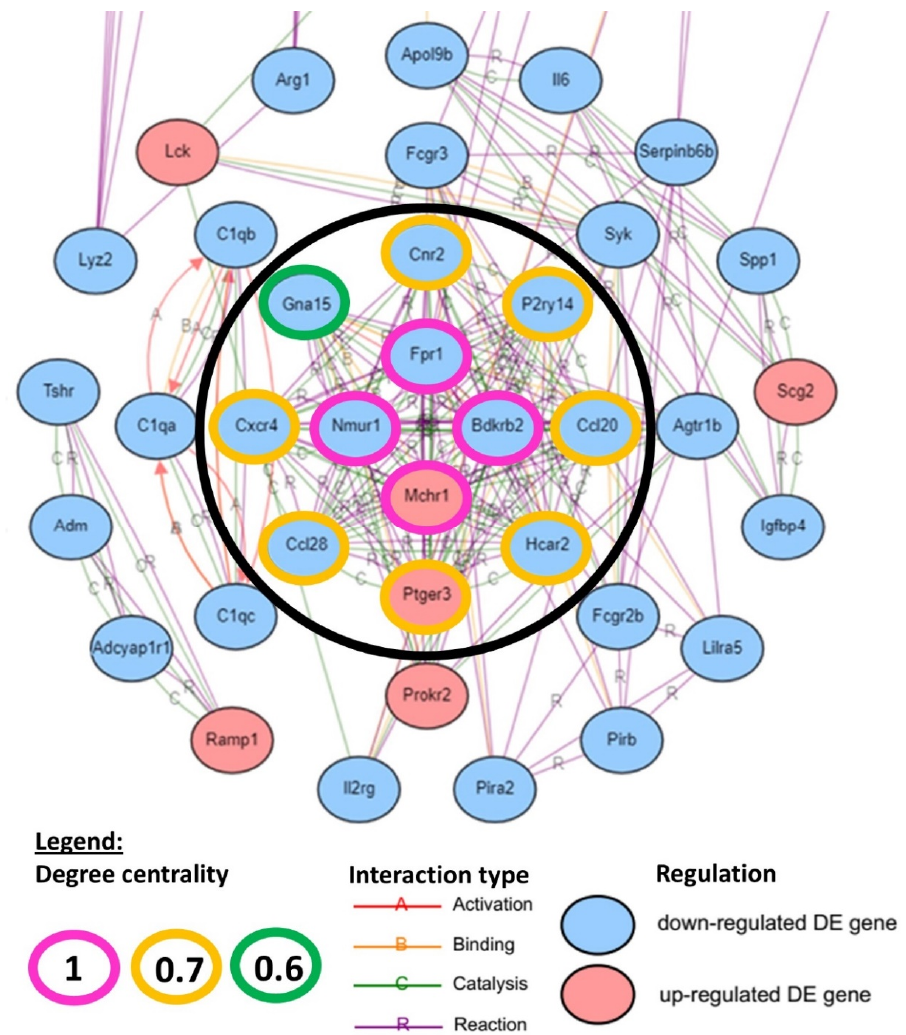
Figure 2. Hub gene network. DEGs with the highest degree of centrality are shown in the center of the wheel-shaped network within the black circle. Pink indicates DEGs with a degree equal to 1. Orange indicates DEGs with a degree equal to 0.7, and green indicates DEGs with a degree equal to 0.6. Genes that are upregulated in hIGFBP5 fibroblasts are shown in red, those that are downregulated are shown in blue.